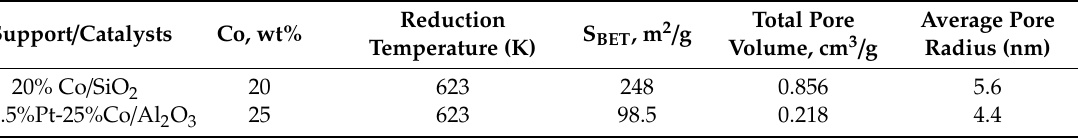
Table 8. Surface area and pore size distribution of silica-supported cobalt